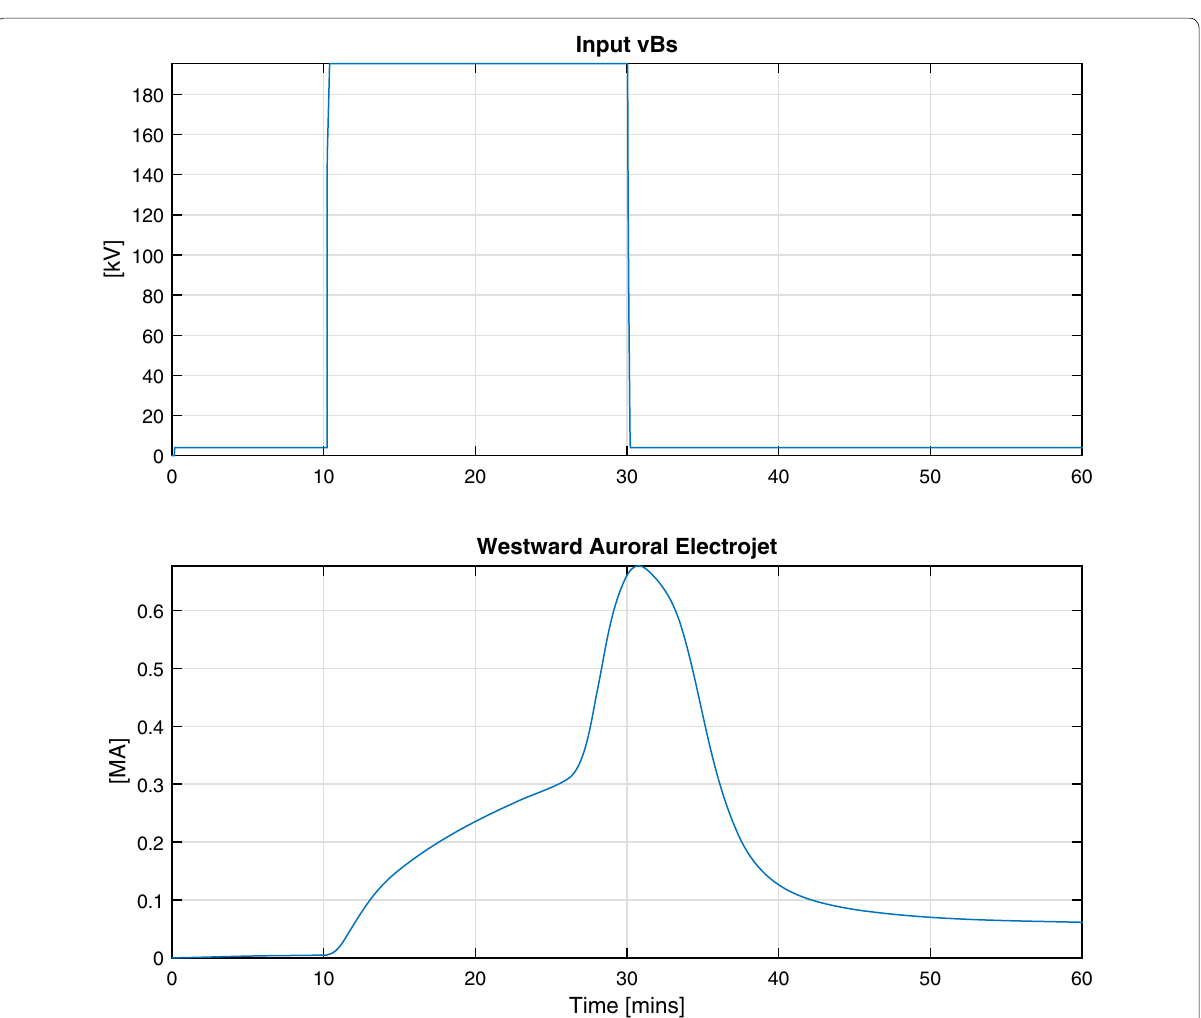
Fig. 1 WINDMI under 191-kV input. The WINDMI model is driven with a synthetic southward IMF voltage signal with the solar wind velocity Vx being 450 km/s and IMF Bz of 6.67 nT. A substorm is produced when sufficient energy is stored in the magnetotail and a critical current I c is − reached